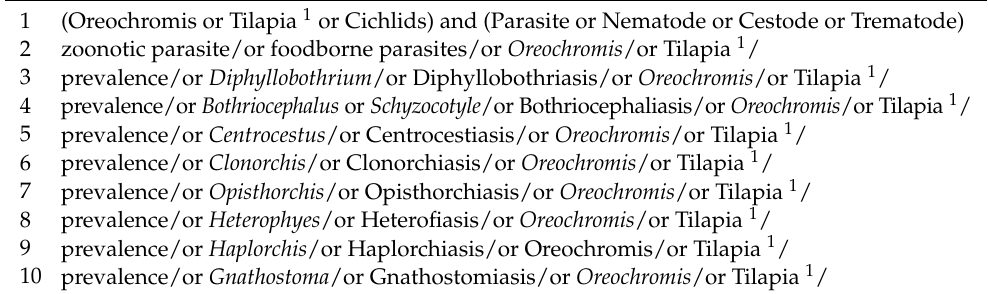
Table 1. Search strategy for zoonotic parasites studies that affect